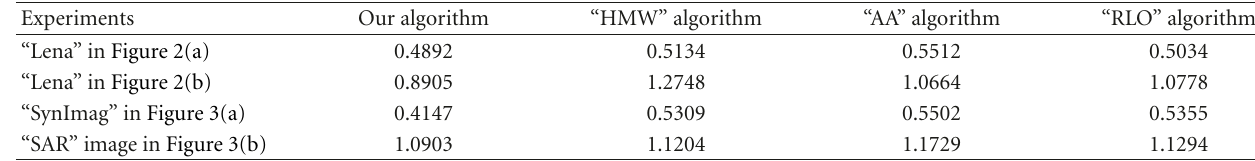
Table 3: The mean square error between the line of the original images and the restored images using four algorithms.